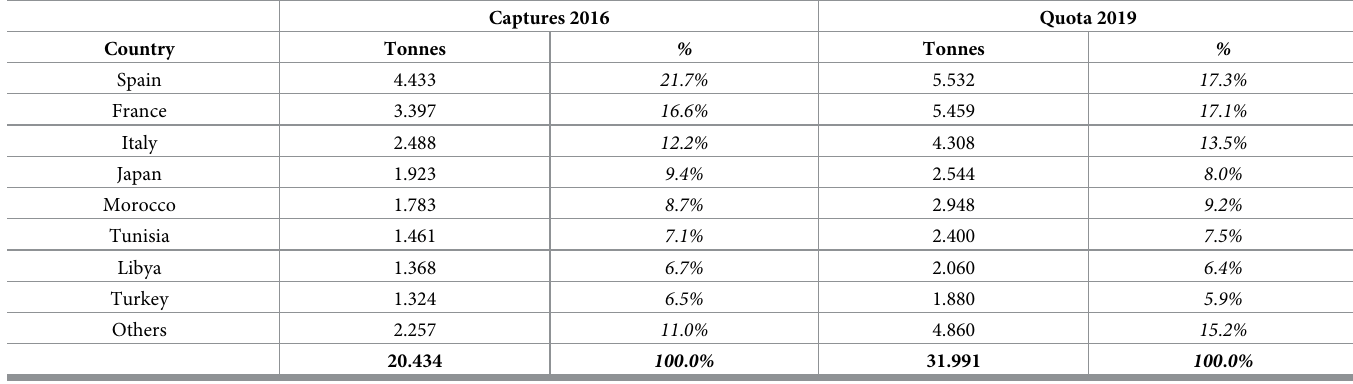
Table 2. Thunnus thynnus catches and quota per country.